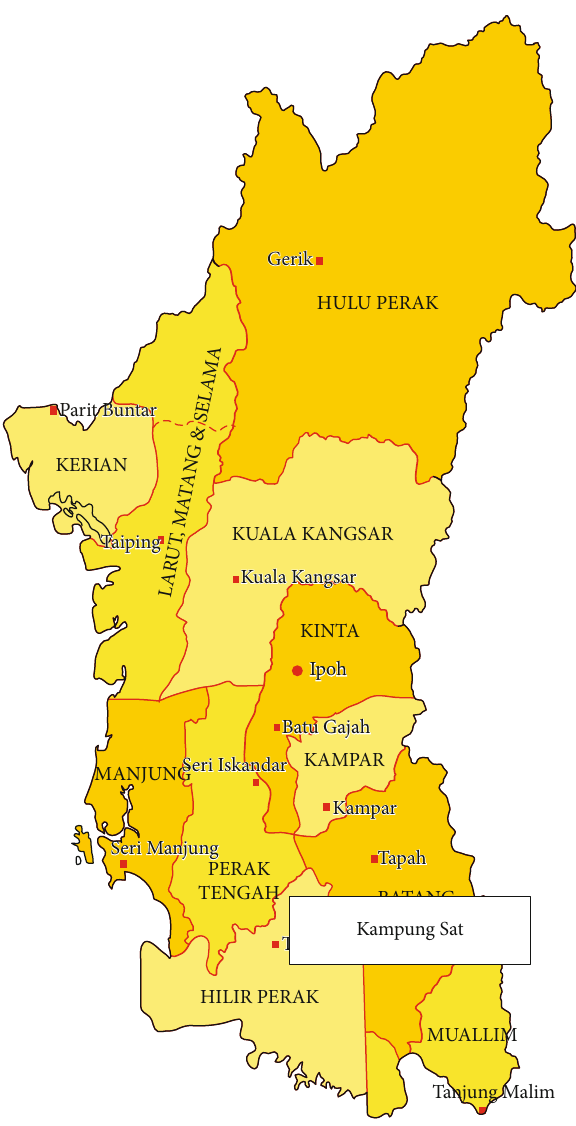
Figure 1: Map of Kampung